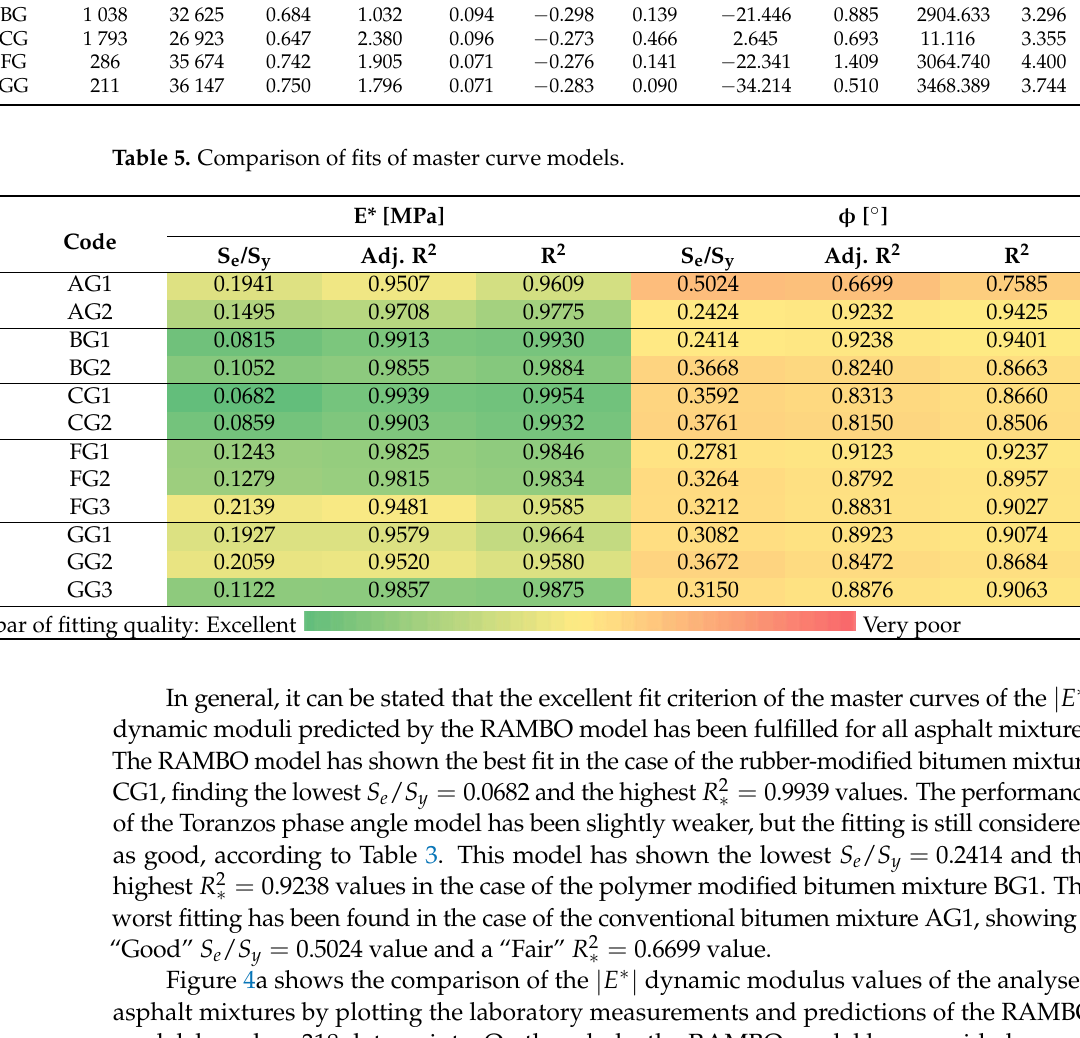
Table 4. Average model parameters of master curves.